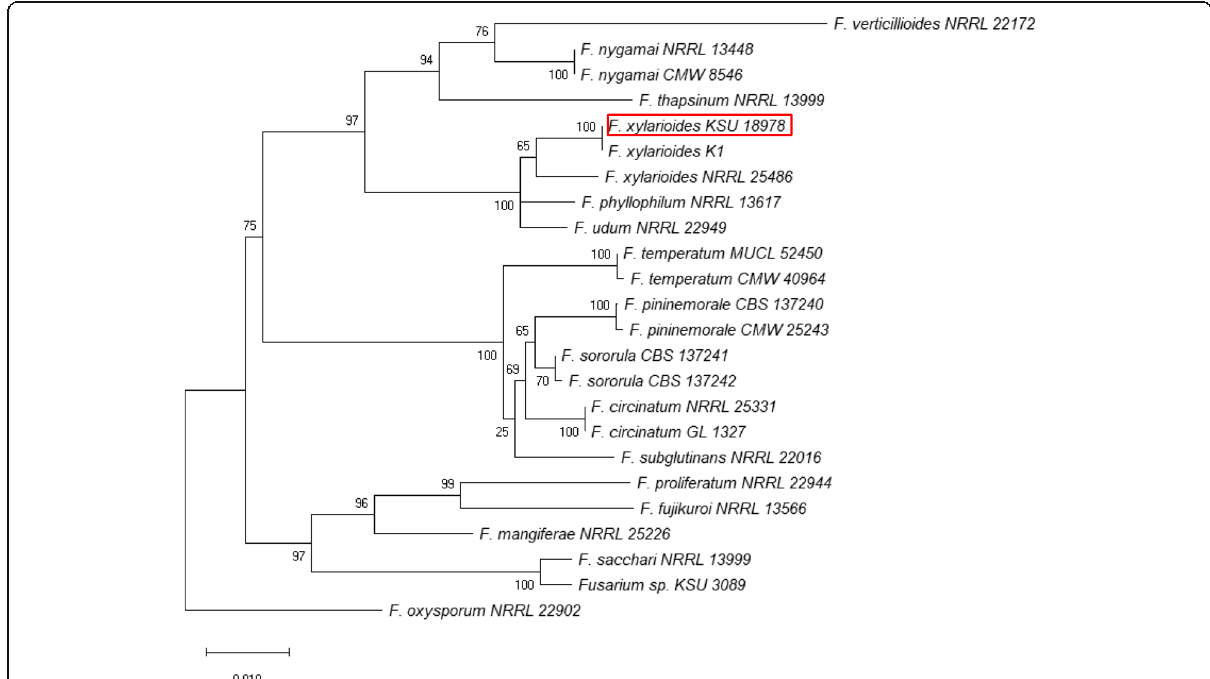
Fig. 2 Maximum likelihood (ML) tree based on partial gene sequences of β -tubulin and translation elongation factor 1- α . Sequence alignments were assembled with MAFFT version 7 (Katoh and Standley 2013). The program MEGA X version 7 (Kumar et al. 2018) was used to estimate the best-fit substitution model (TN93) with a discrete gamma distribution ( +G ). The same program was used for ML phylogenetic analysis and